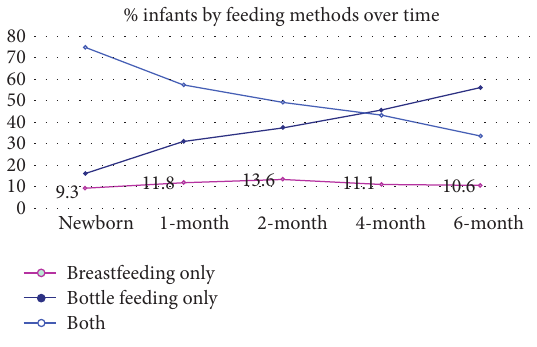
Figure 1: Feeding method in first 6 months of